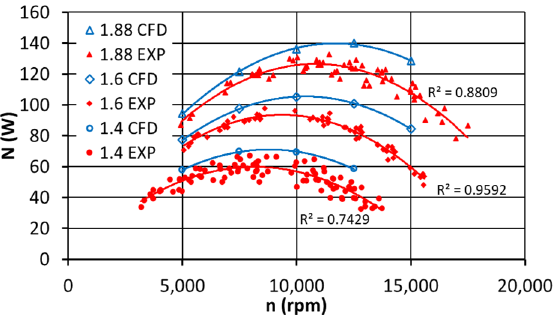
Figure 9. Power as a function of rotational speed for different pressure ratios.